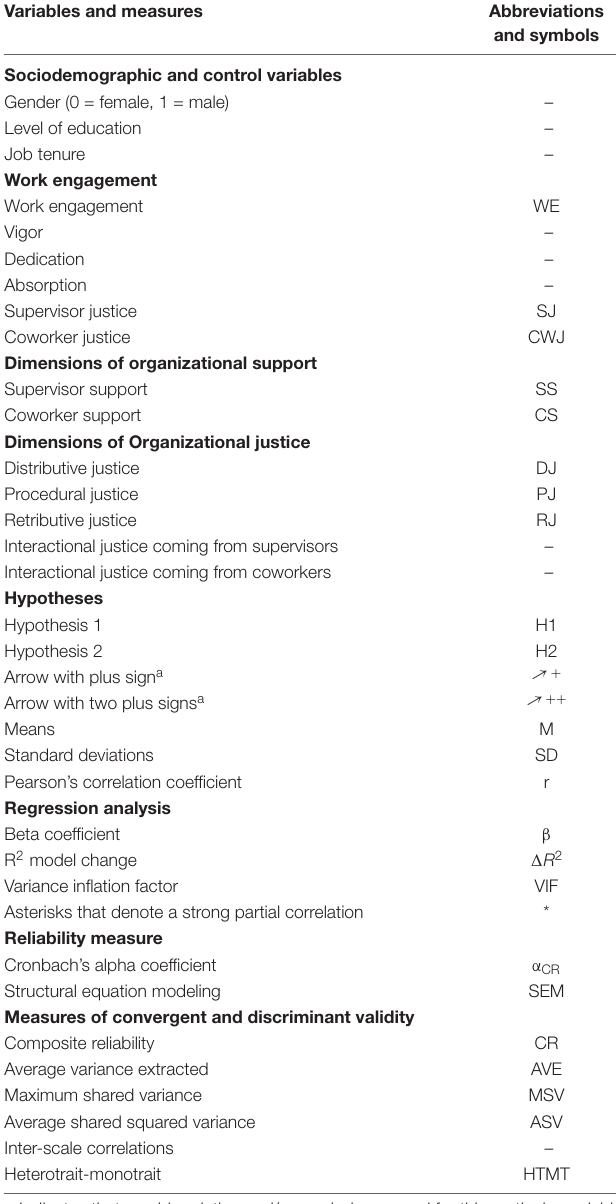
TABLE 1 | Overview of different variables, measures, abbreviations, and symbols used in the present study. Variables and